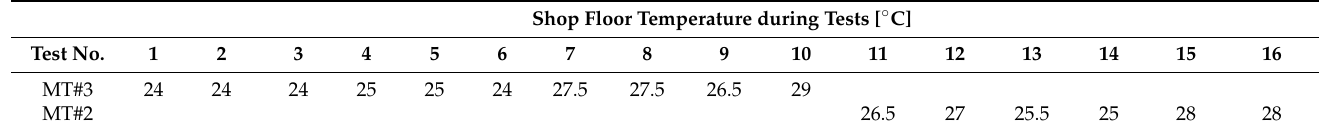
Table 12. Temperature variation of shop floor area in relation to test